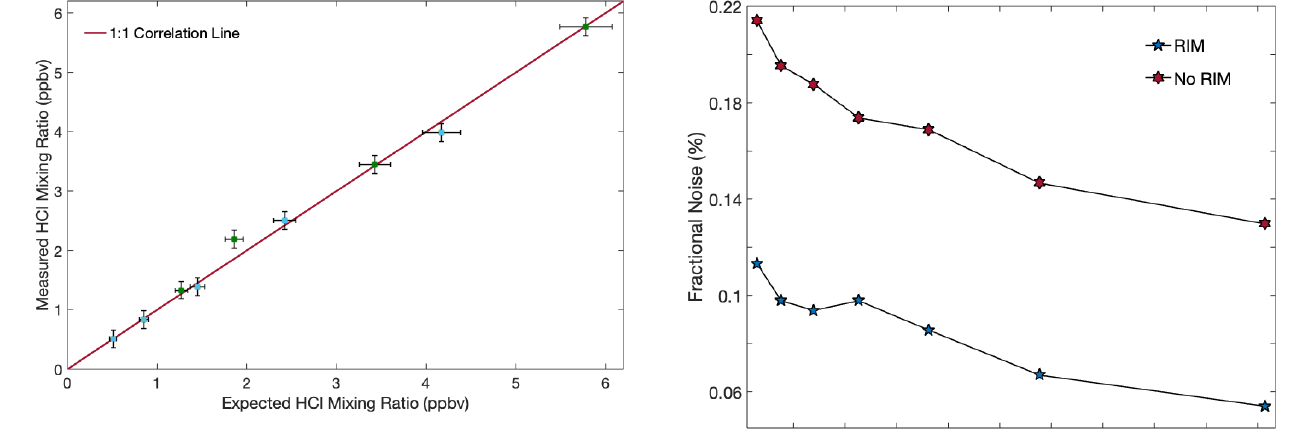
Figure 5. Observed HCl mixing ratio after sequential dilution of original HCl cylinder to illustrate that the instrument responds lin- early to different input mixing ratios. Each point represents an ap- proximately 1min average of 1Hz spectra. The cell was heated to 315K, and the cell pressure was around 24hPa. Vertical bars represent 1 σ precision for the instrument readout. Horizontal bars represent the combined uncertainty of the input HCl cylinder and the pressure readings used to quantify dilution. The blue and green points indicate the two separate iterations of the experiment.